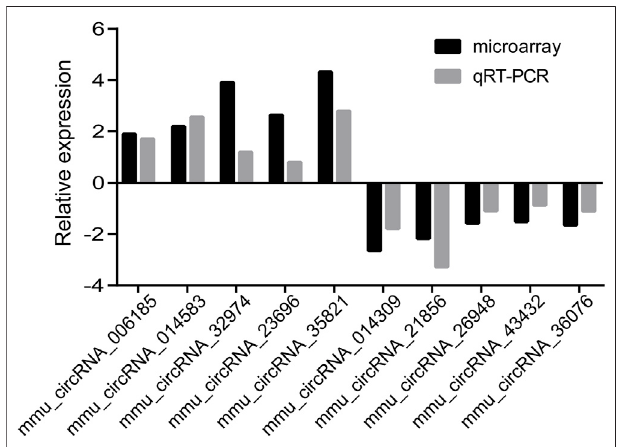
FIGURE 3 | Relative fold changes of 10 randomly selected circRNAs by qRT-PCR and microarray. The downwards indicates downregulation, while upwards indicates